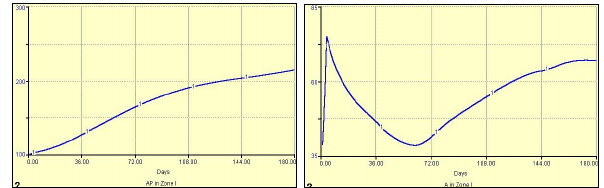
Figure 20. Simulation results for the main ecological indices for zone 1. (a) Aquatic plant biomass (AP); (b) phytoplankton biomass (A).